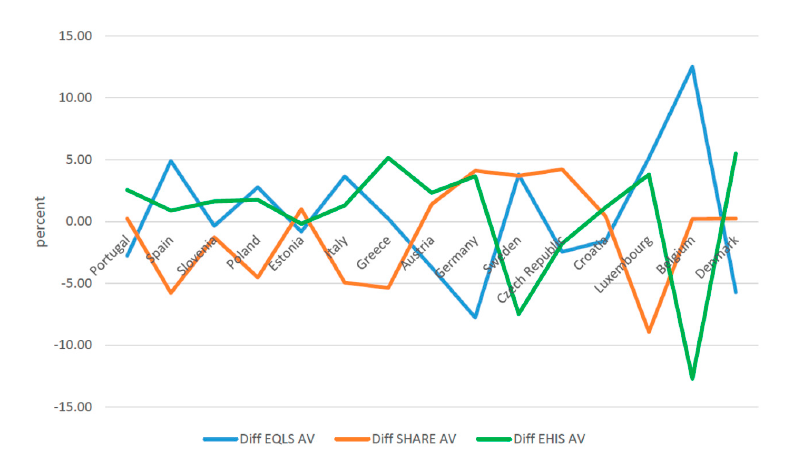
Figure 5. Di ff erence between Informal Caregivers over 50 and average, females (weighted) (percent). EQLS = European Quality of Life Survey; SHARE = Survey of Health, Ageing and Retirement in Europe; EHIS = European Health Interview Survey; AV =